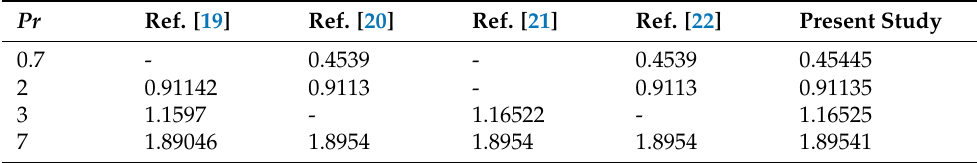
Table 1. Comparison results for − θ (cid:48) ( 0 ) with K = 0, Ec = 0.0, M = 0.0.